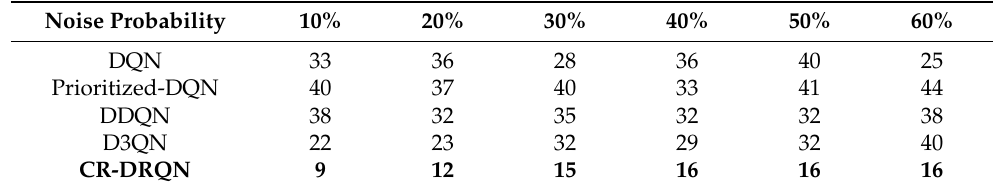
Table 3. Average change times of the ego vehicle’s acceleration at different probabilities of noise occurrence after 30